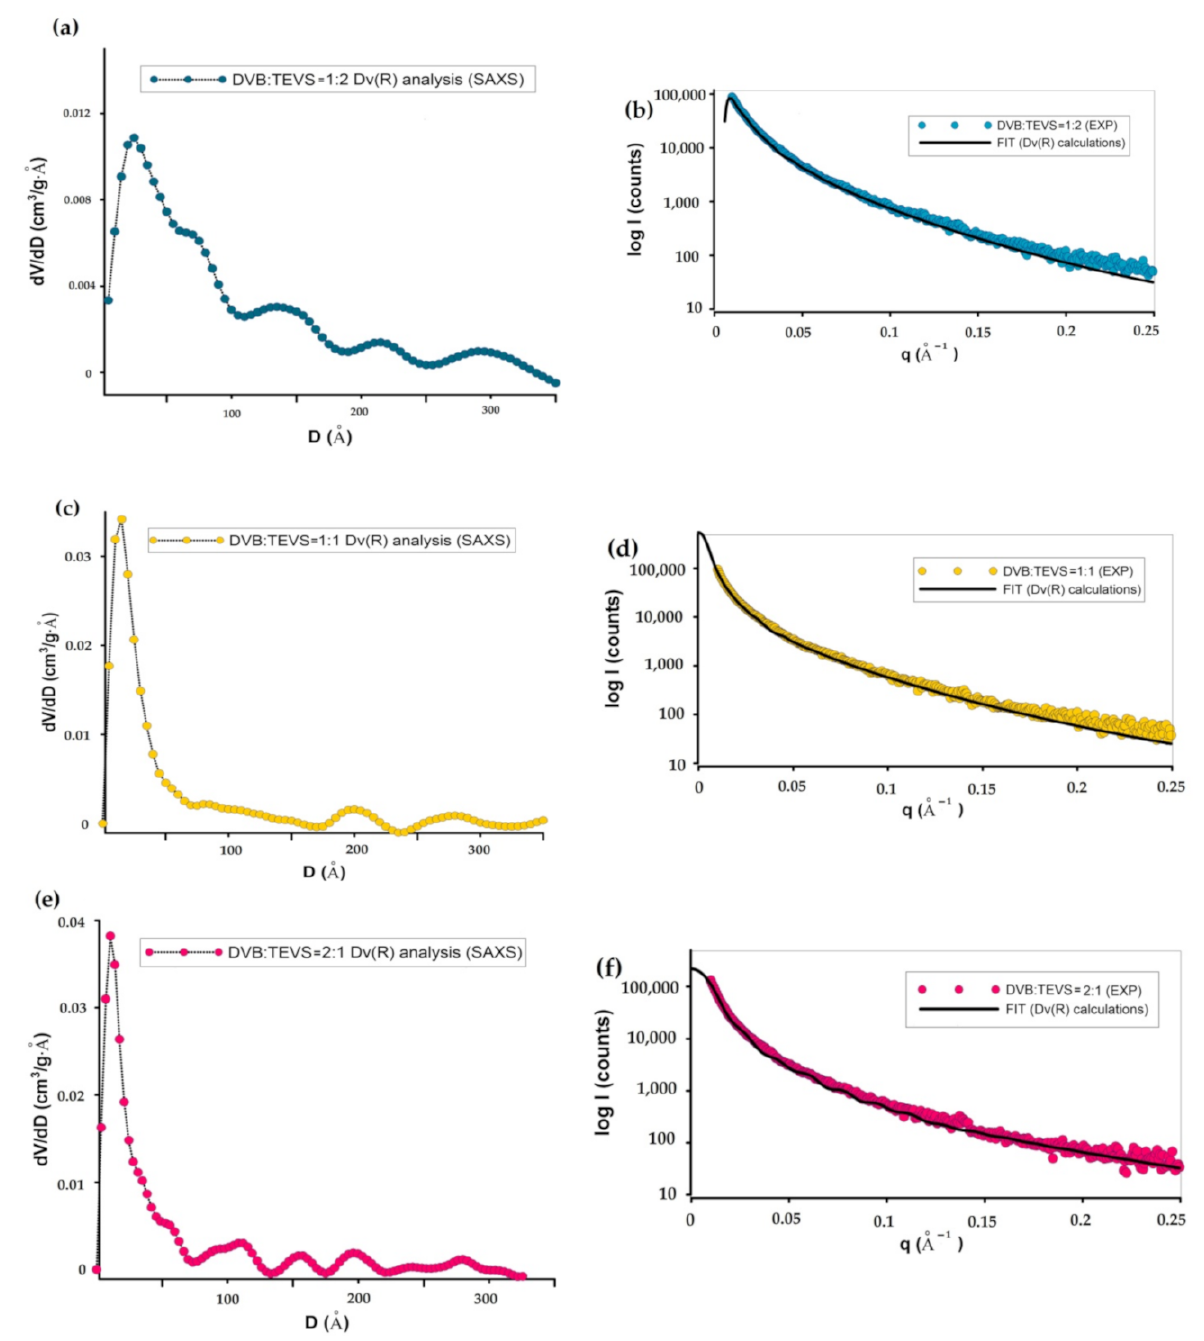
Figure 4. Particle Size Distribution by volume analysis Dv(R) for investigation systems: DVB:TEVS = 1:2 ( a ), DVB:TEVS = 1:1 ( c ) and DVB:TEVS = 2:1 ( e ). The insets of plots correspond to fit curves extrapolated for experimental SAXS data ( b , d , f